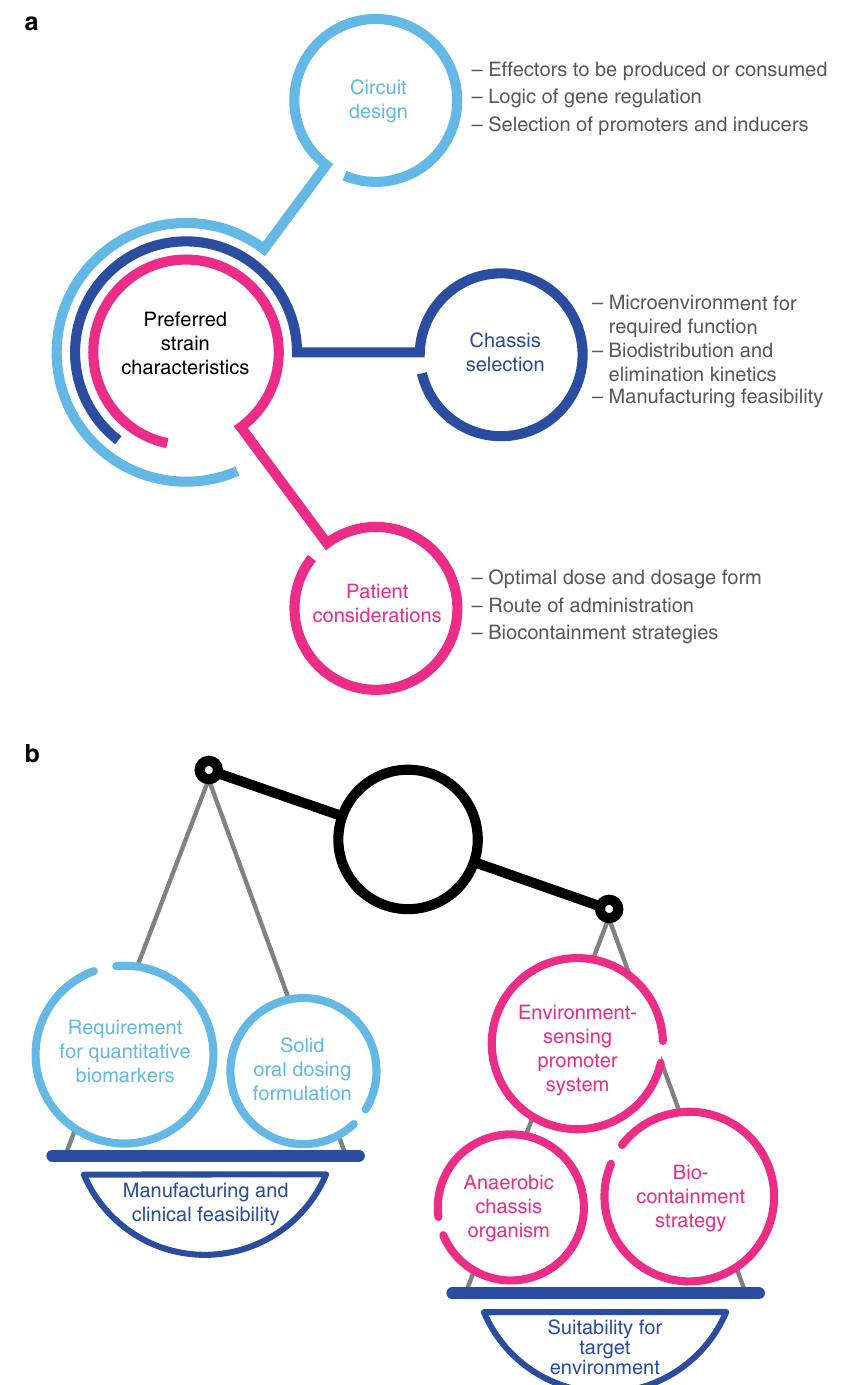
Fig. 1 Considerations for the design of engineered live bacterial therapeutics. a Several aspects require consideration during the design of an engineered bacterial therapeutic. The selection of a chassis organism can be guided by the desired site of activity and pharmacokinetic properties of the chassis, as well as manufacturing feasibility. The design of genetic circuits may also be in fl uenced by the circuit ’ s effectors, pragmatic concerns regarding inducer compounds, and the genetic stability of regulatory circuits. Critically, the design of an engineered bacterial drug may also be constrained by considerations for the needs of patients. b Optimal strain design often requires a balance between strain suitability for function in the target microenvironment and concerns for feasibility of manufacturing and clinical